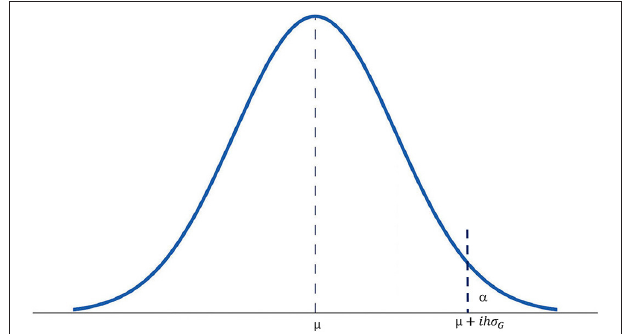
FIGURE 1 | A chart of normal distribution to show the relationships among various parameters in the Complete Breeder’s Equation. µ is the mean of the breeding population; σ G is the square root of the genotypic variance of the population; i is the artificially set selection intensity in the unit of σ G ; h is the square root of achieved heritability ( h 2 or H ); α is the portion of the population to be selected; it is also the probability that the best genotypes are not included in the selected